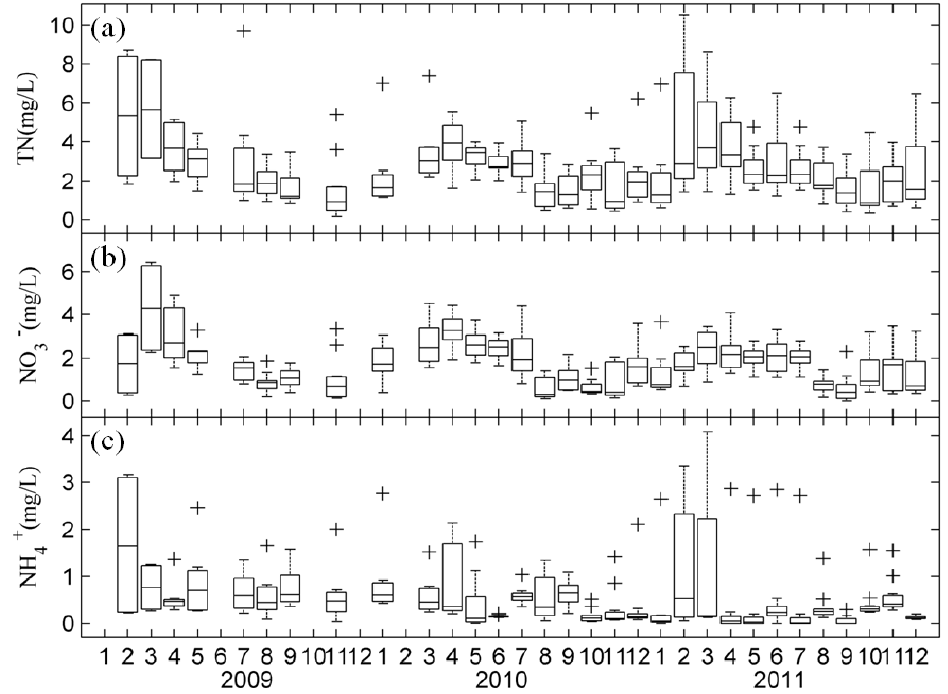
Figure 2. Monthly variability of TN, NO ( c ) NH 4+ boxplot based on nine sites. The crosses “+” represent